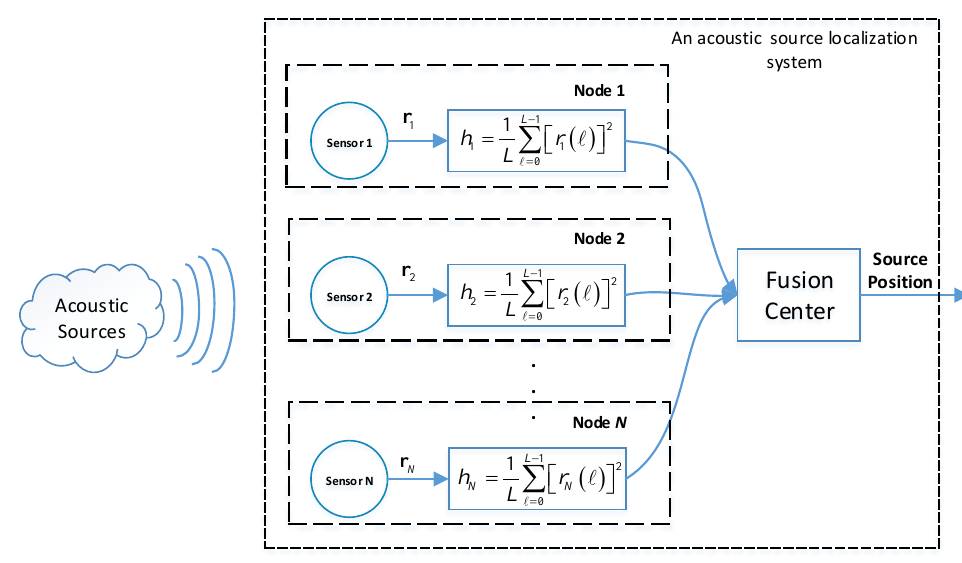
Figure 2. The block digram of energy-based acoustic source localization in a sensor